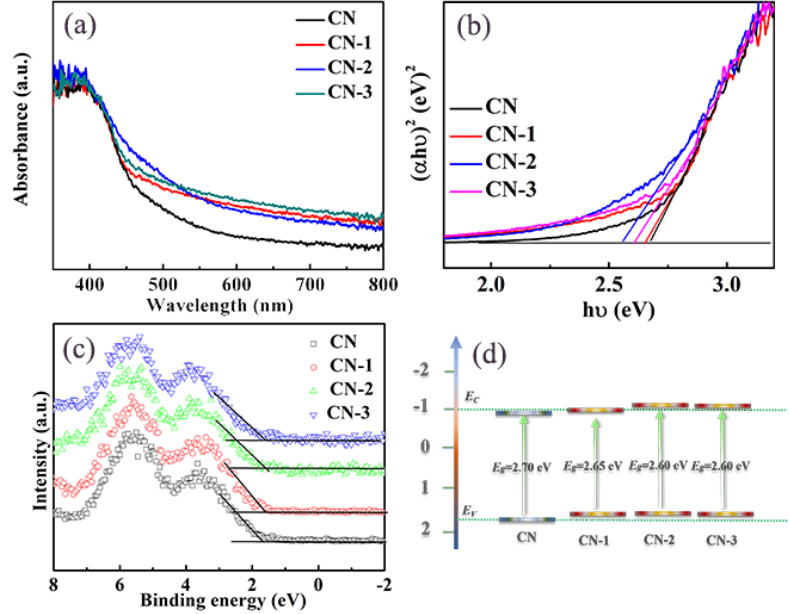
Figure 4. ( a ) UV-vis diffuse reflectance spectra, ( b ) ( α h ν ) 2 versus h ν plot, ( c ) XPS valence, band spectra, and ( d ) Schematic band structure evolution of different samples.